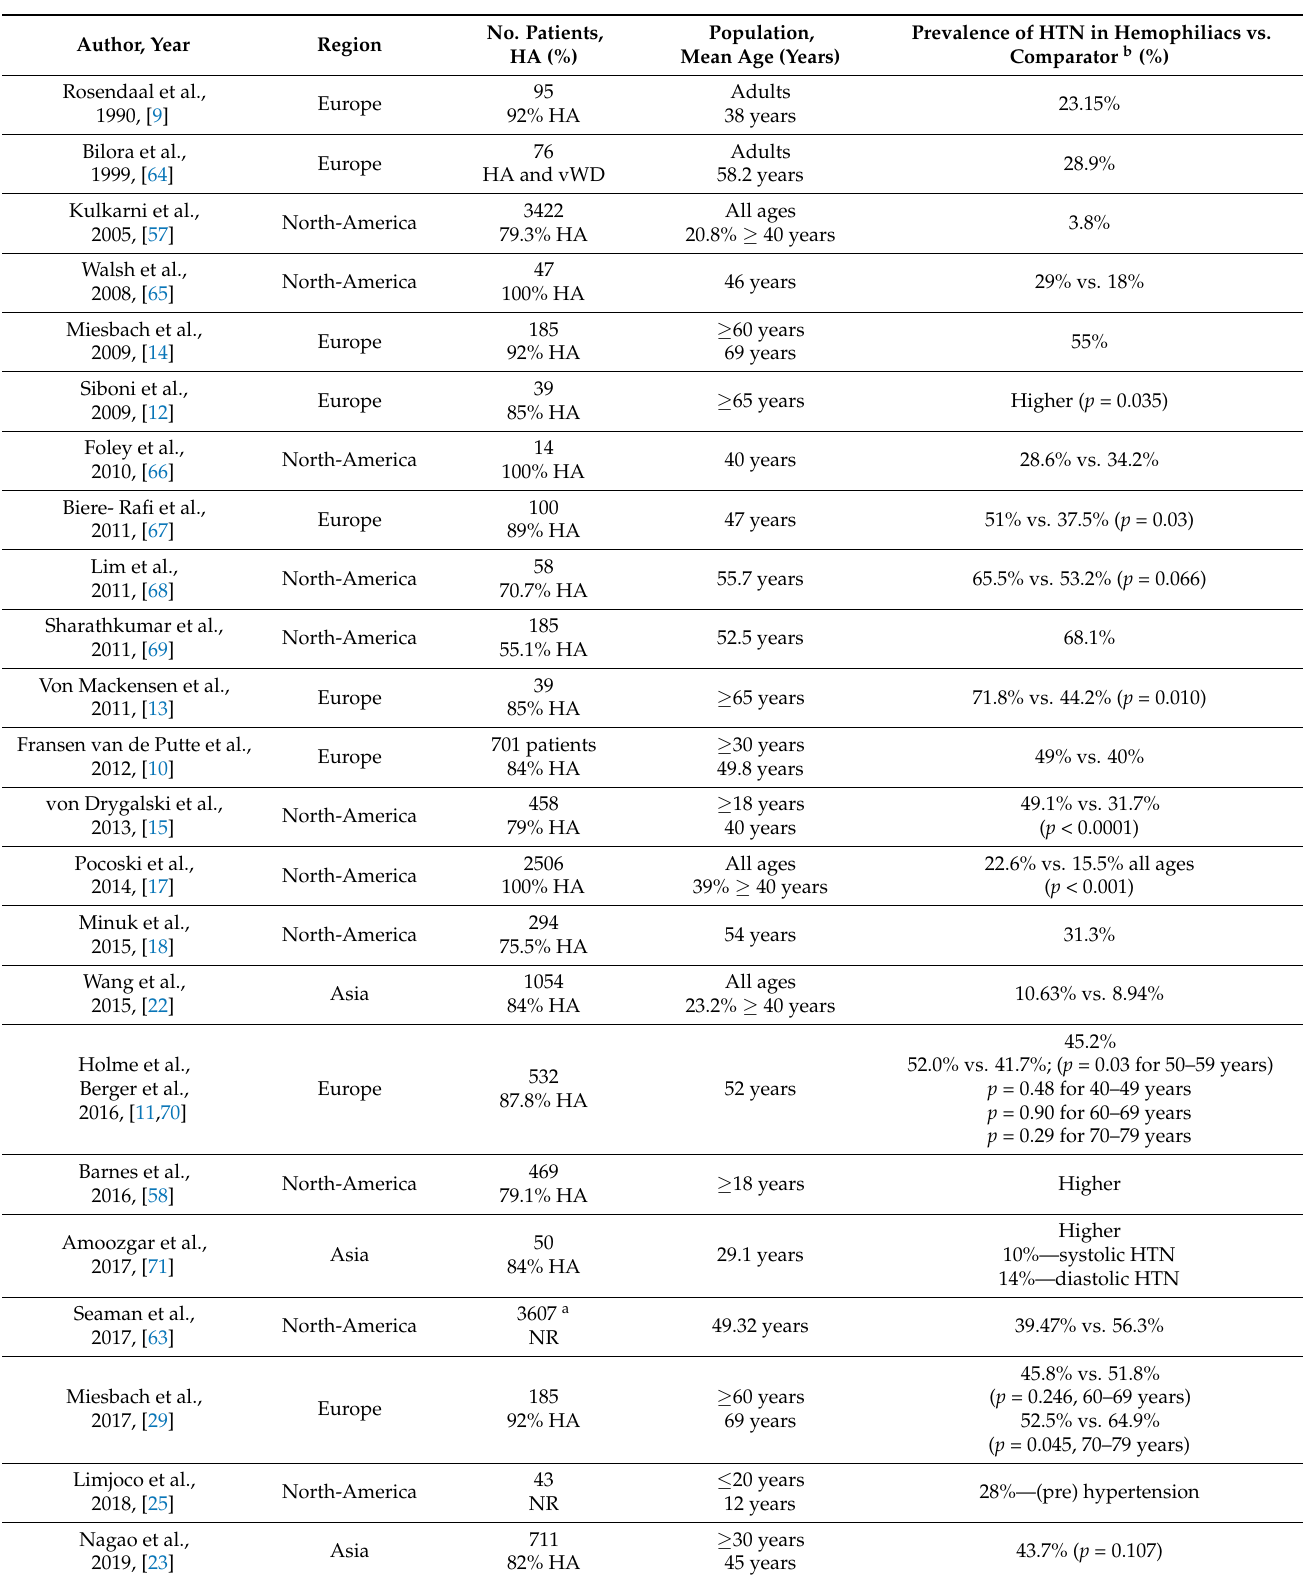
Table 1. Prevalence of HTN in patients with congenital